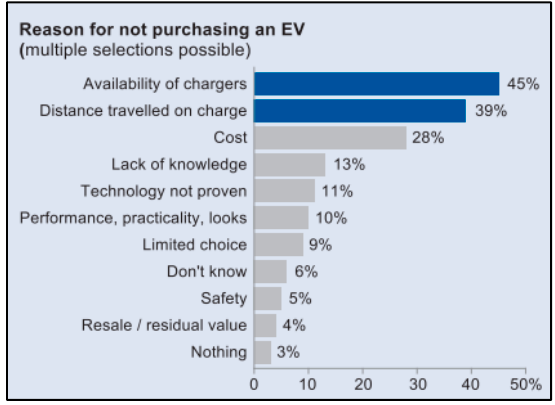
Figure 1. Top reasons for not purchasing an electric vehicle (EV) [1] .